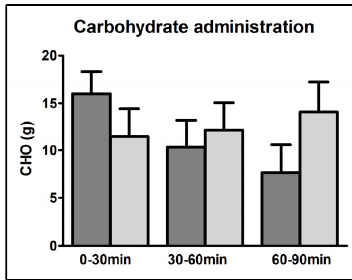
Figure 1. Carbohydrate administration during first, second, and third 30 min-intervals of exercise. GLUFRU (glucose-fructose co-ingestion) = dark grey bar and GLU (glucose alone ingestion) = light grey bar. Results are expressed as mean ± SEM.